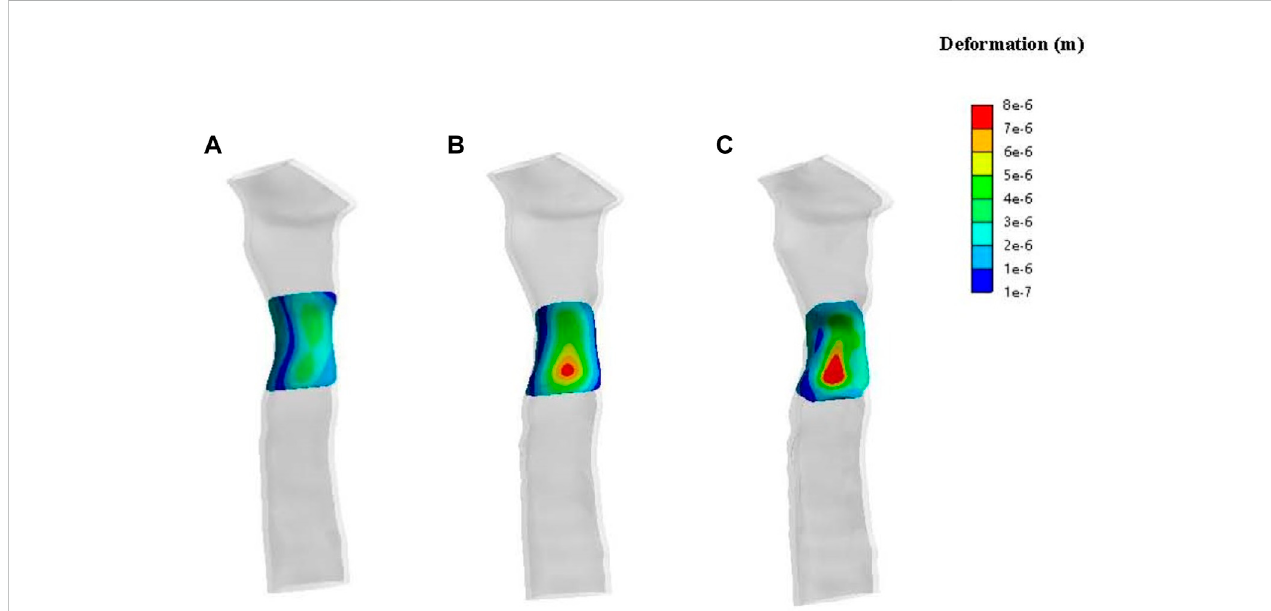
FIGURE 8 Contours of deformation on the patch for patient one. The lateral view of a normal trachea (A) , a trachea with 33% stenosis (B) and a trachea with 50% stenosis (C) .